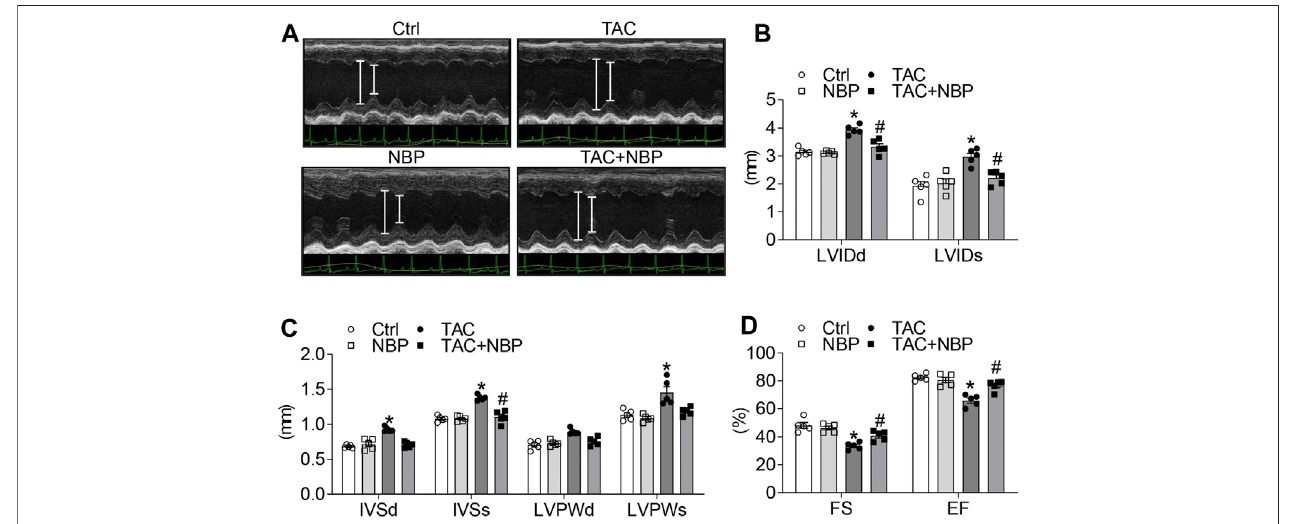
FIGURE2| NBPprotectsagainstTAC-inducedcardiacdysfunction invivo .EchocardiographicdatashowingtheeffectsofNBPoncardiacdysfunctioninducedby TAC. (A) Representative images of M-mode of left ventricular. (B) LVIDd and LVIDs. (C) IVSd, IVSs, LVPWd, and LVPWs. (D) Ejection fraction (EF); fractional shortening (FS). (n (cid:1) 5 in each group; *, vs. Ctrl group; #, vs. TAC group; * and # p <